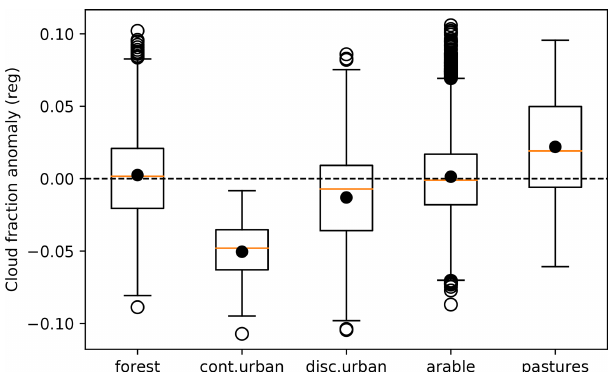
Figure 7. Cloud fraction CF reg anomaly from the Regional Empir- ical Cloud Detection Approach constrained by meteorological con- ditions (Fig. 6) and grouped by five main CORINE land cover types: forest, continuous urban fabric, discontinuous urban fabric, arable land and pastures. Details are the same as in Fig. 5.